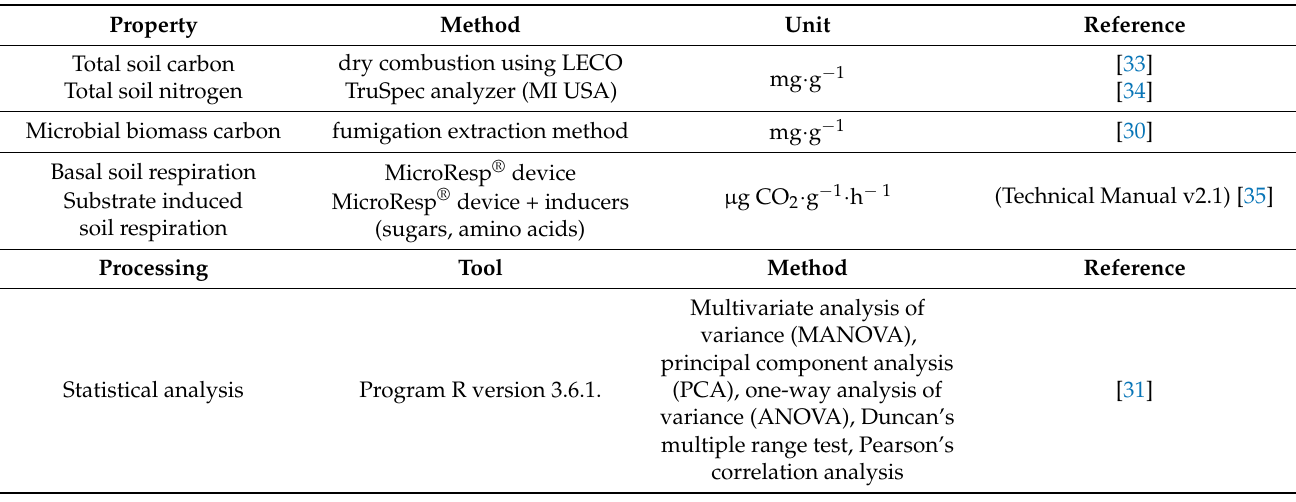
Table 2. Methods used to determine the soil properties for statistical analysis with relevant